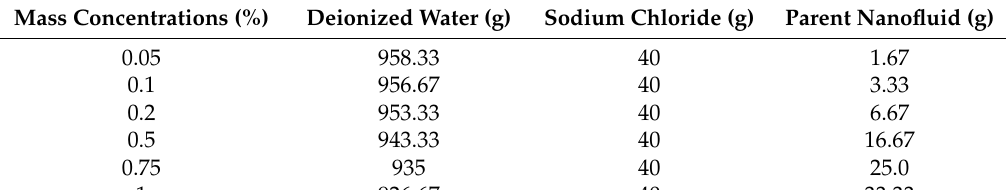
Table 3. The composition of different concentrations of silica nanofluids.